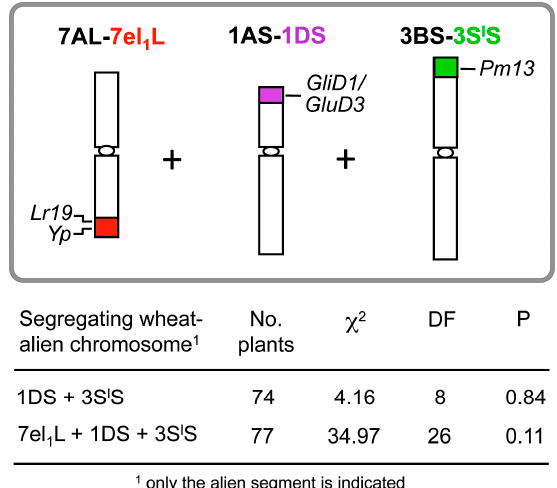
Figure 1. Wheat-alien recombinant chromosomes transferred into durum wheat and the simultaneous transmission ability of two and all three of them in F 2 progenies of selfed heterozygotes.